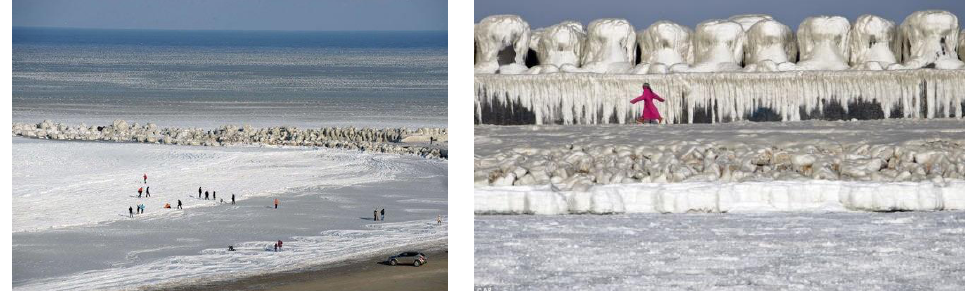
Figure 1. Romanian coast near Constanta in February 2012 [11].